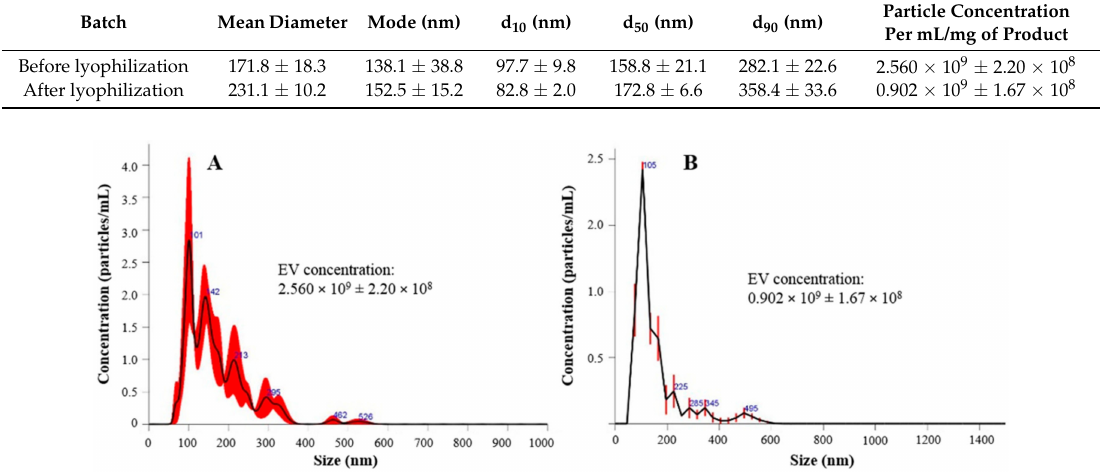
Figure 2. EVs particle concentration and size distribution before ( A ) and after ( B ) the lyophilization process. In red is indicated the ± standard error of the mean values ( n = 3). EV concentration is expressed as mean value ± standard deviation ( n =